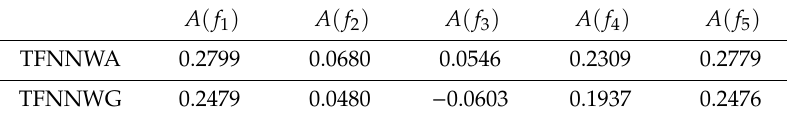
Figure 2. Flow diagram of the calculation procedures for our proposed MABAC method. Table 12. The accuracy function value of alternatives S ( f i ) .